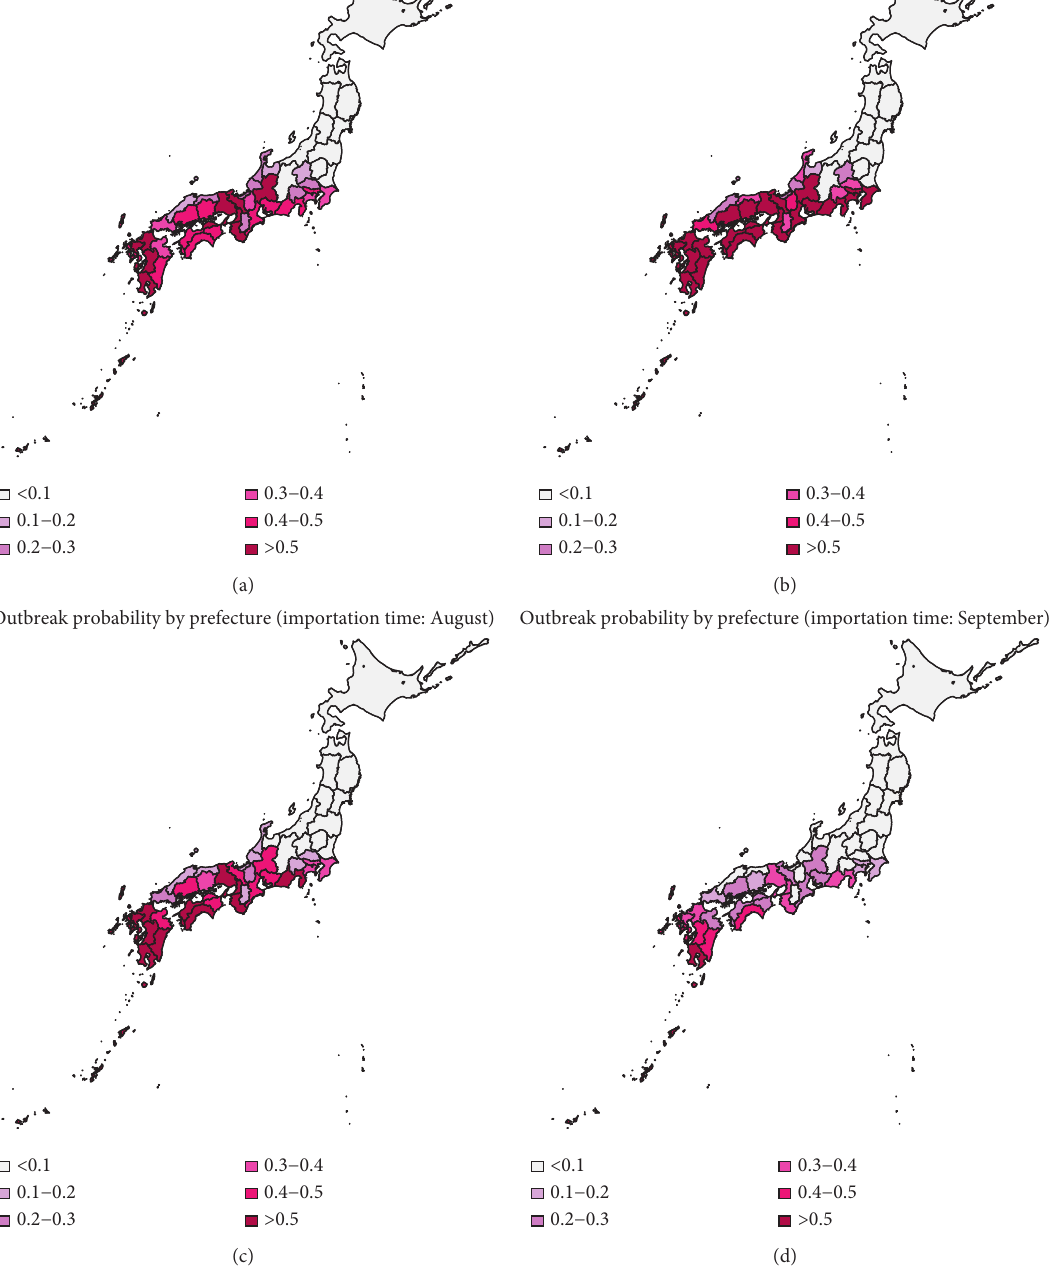
Figure 5: Heat map of the mean probability of outbreak in November (2013–2016), when the infectious individual is imported in June, July, August, and September; k � 0 .